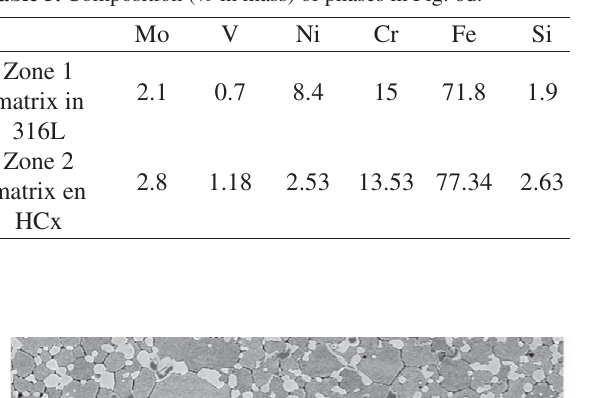
Table 5. Composition (% in mass) of phases in Fig.